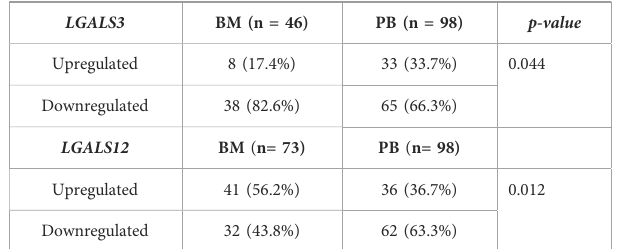
TABLE 4 Expression pro fi le of LGALS3 & 12 in both PB and BM of the AML